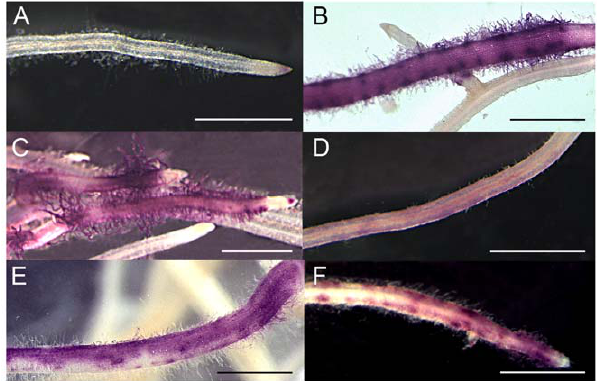
Figure 2. The extracellular domain of SYM10 can replace that of NFP for activation of pMtENOD11:GUS . nfp pMtENOD11:GUS roots untransformed (A) or transformed by pNFP:NFP-NFP (B), pNFP:SYM10-NFP (C), pNFP:LYK3-NFP (D) or pNFP:SYM10-SYM10 (E) and stained for GUS activity 7 dpi with wild type S. meliloti . nfp lyk3 pMtENOD11:GUS roots transformed by pNFP:SYM10-NFP (F). GUS activity is shown in magenta. Bars=1 mm.